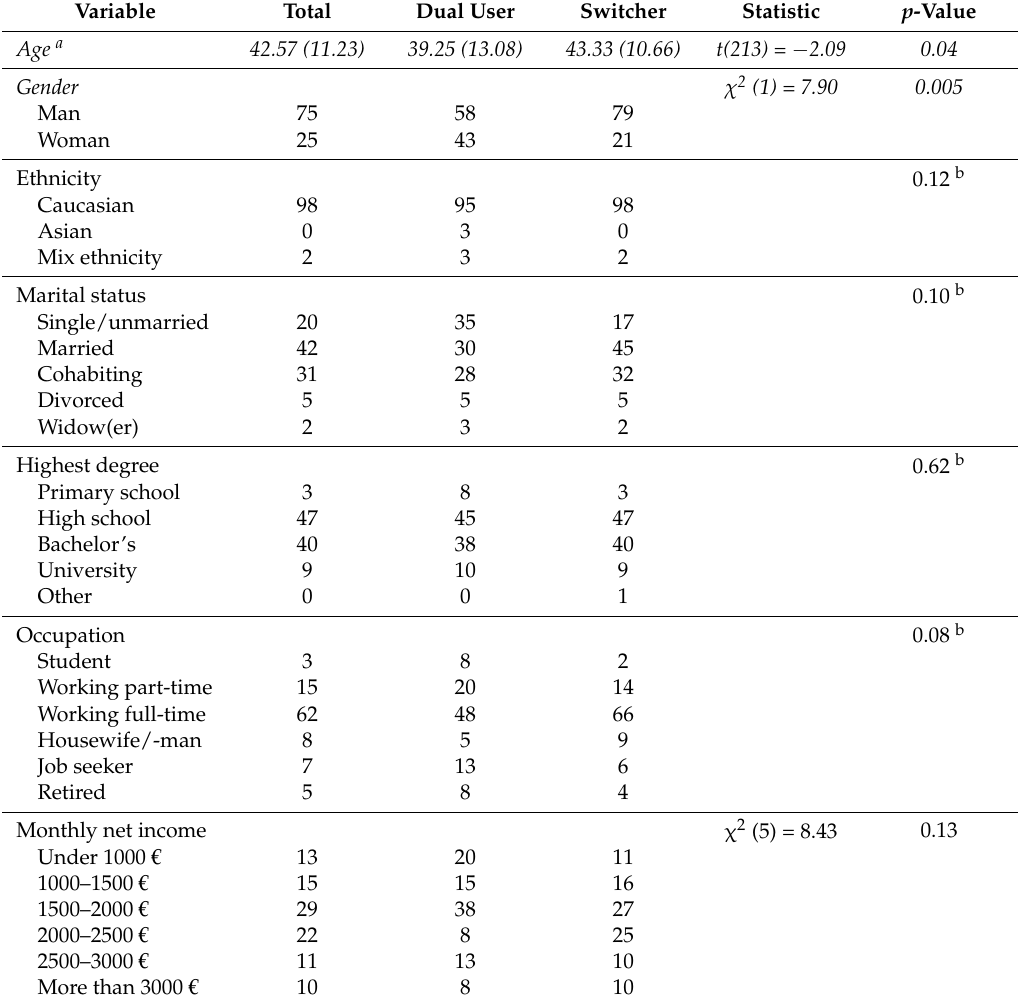
Table 1. Sociodemographic